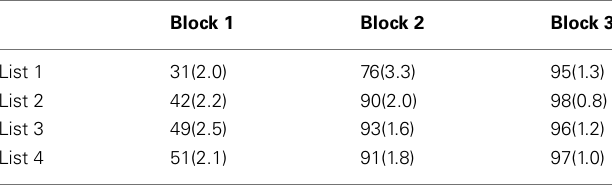
Table 4 | Experiment 1 training scores as a function of list and